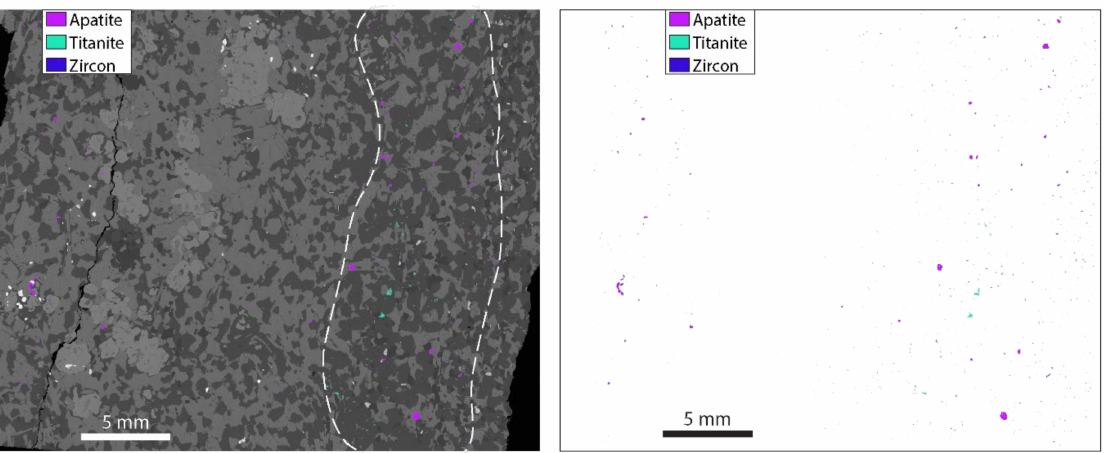
Figure 8. Distribution of the accessory phases in sample 6KB67 with and without the BSE underlay. The dashed white line in the left panel shows the band that contains the majority of the accessory phases in thin